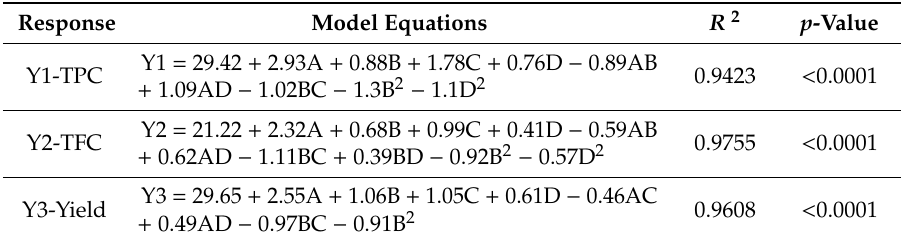
Table 4. Empirical second-order polynomial model of total phenolic content (TPC), total flavonoid content (TFC) and Yield.